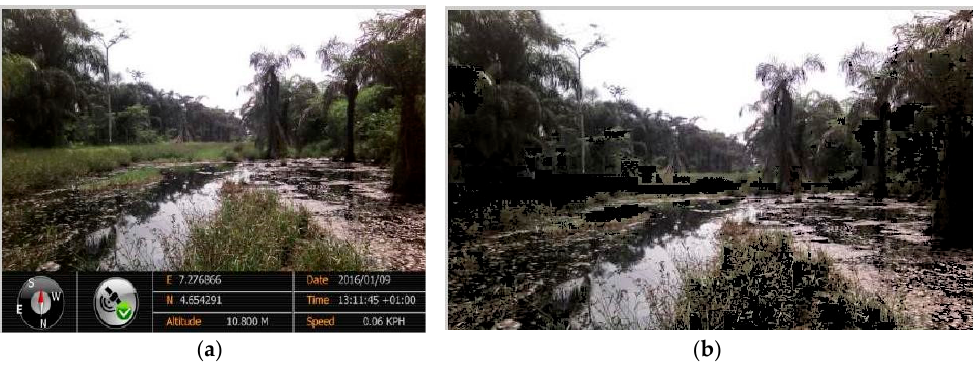
Figure 4. Effect of RGB color range overlap on color segmentation stage in spill detection algorithm. ( a ) Sample image OS25 with negative spill detection result; ( b ) Color Segmentation result for OS25 showing algorithm’s failure to eliminate dark green vegetation.